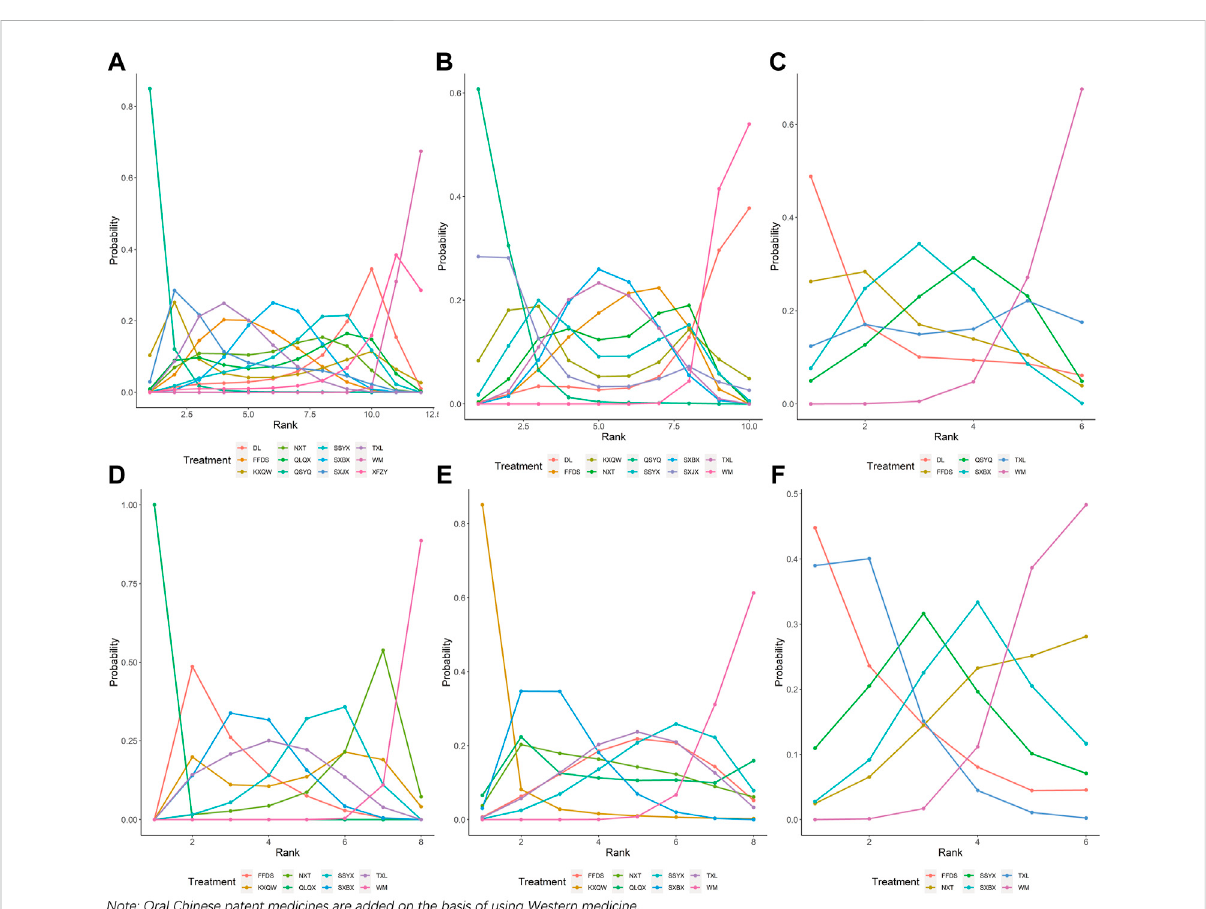
FIGURE 4 Ranking probability at each level for the included interventions. (A) Weekly frequency of angina; (B) Duration of an angina attack; (C) Weekly nitroglycerinusage; (D) EffectiverateinECG; (E) Clinicaleffectiverate; (F) Cardiovasculareventsrate;WM,Westernmedicine;FFDS,FufangDanshen dripping pill; DL, Danlou tablet; KXQW, Kuanxiong aerosol; NXT, Naoxintong capsule; QLQX, Qiliqiangxin capsule; QSYQ, Qishen Yiqi dripping pill; SSYX, Shensong Yangxin capsule; SXBX, Shexiang Baoxin pill; SXJX, Suxiao Jiuxin pill; TXL, Tongxinluo capsule; XFZY, Xuefu Zhuyu